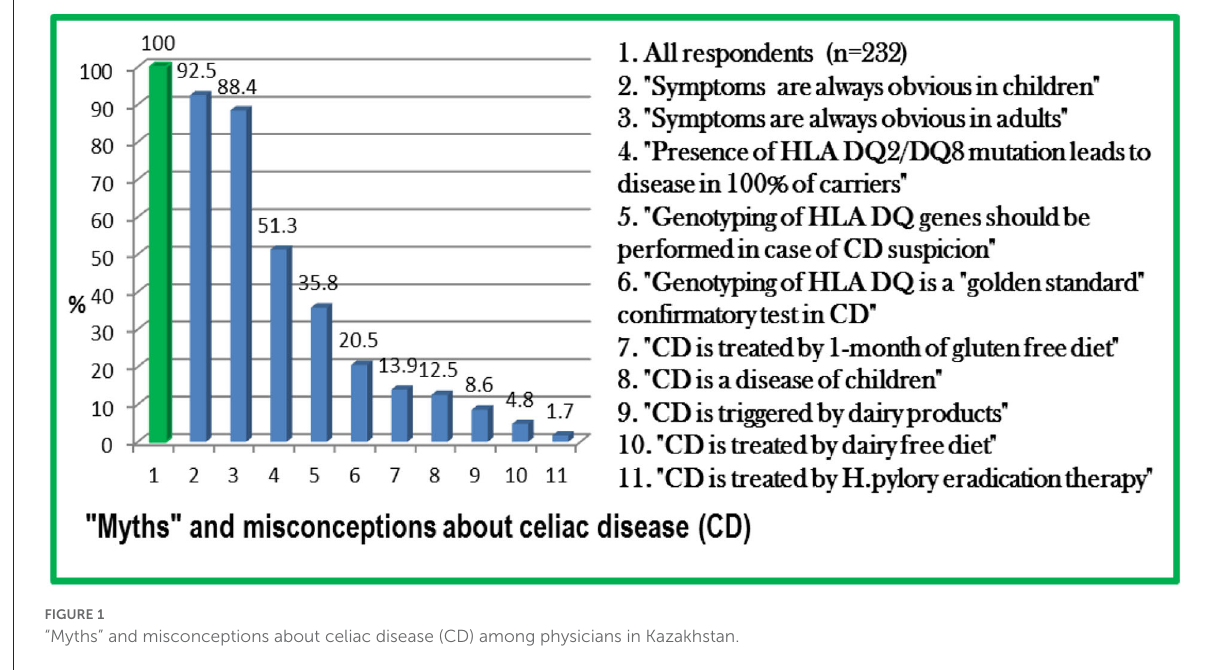
FIGURE1 “Myths” and misconceptions about celiac disease (CD) among physicians in